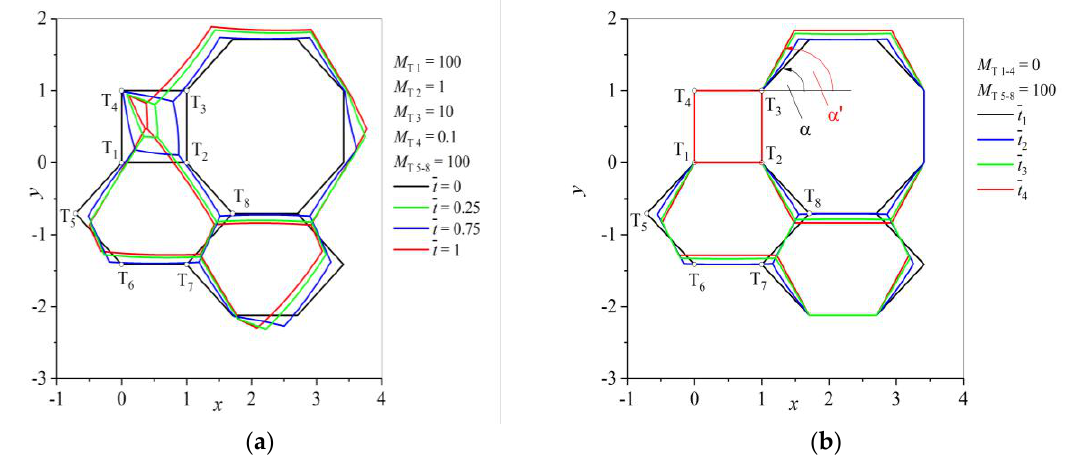
Figure 9. Evolution of the grain arrangement for di ff erent normalized times t . ( a ) Case VII: all triple point mobilities not adjacent to grain I are set to high values, and the triple point mobilities of grain I are all distinctly di ff erent: Mobility M T 1 = 100, M T 2 = 1, M T 3 = 10 and M T 4 = 0.1 set to 1, all other triple point mobilities are set M T 1,5–8 are set to 100. ( b ) Case VIII: The triple points 1-4 of grain I are pinned.